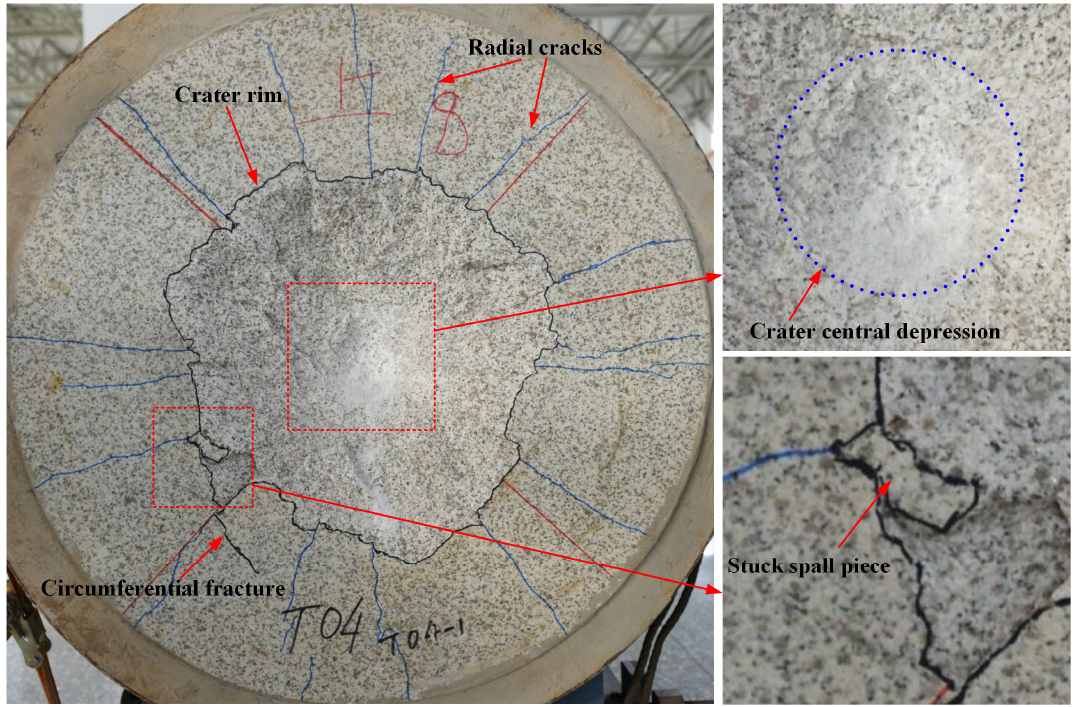
Figure 5. Morphological characteristics of a typical experimental impact crater in granite (Shot No. 9).